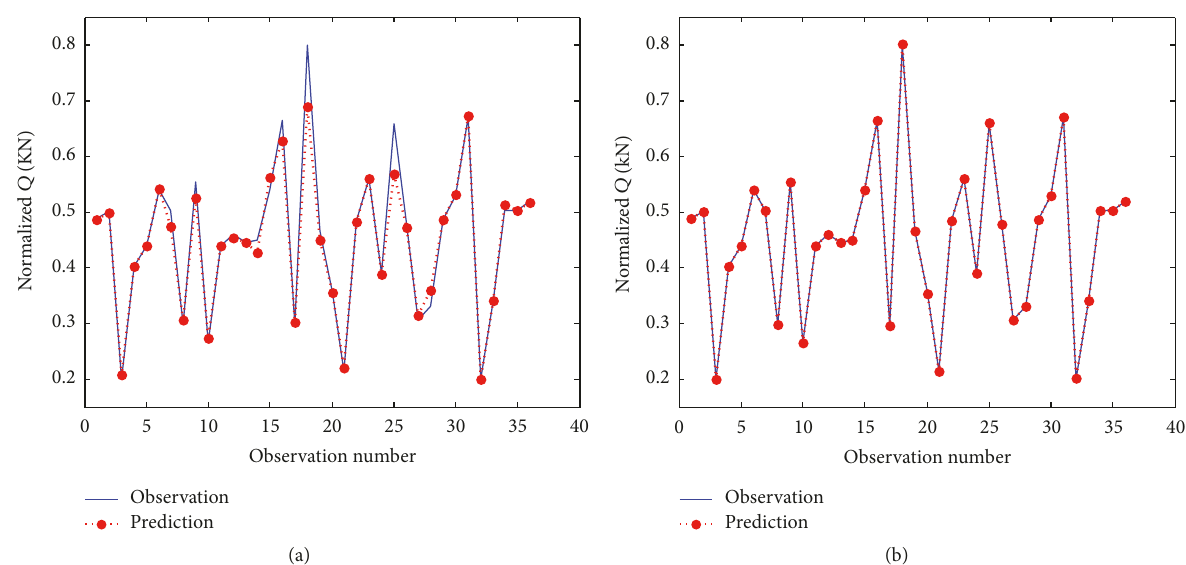
Figure 7: Testing performance of the designed models (a) NHW and (b) DANFIS.